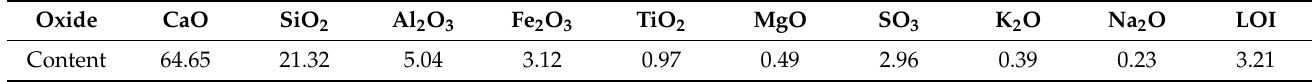
Table 1. Compositions of cement,